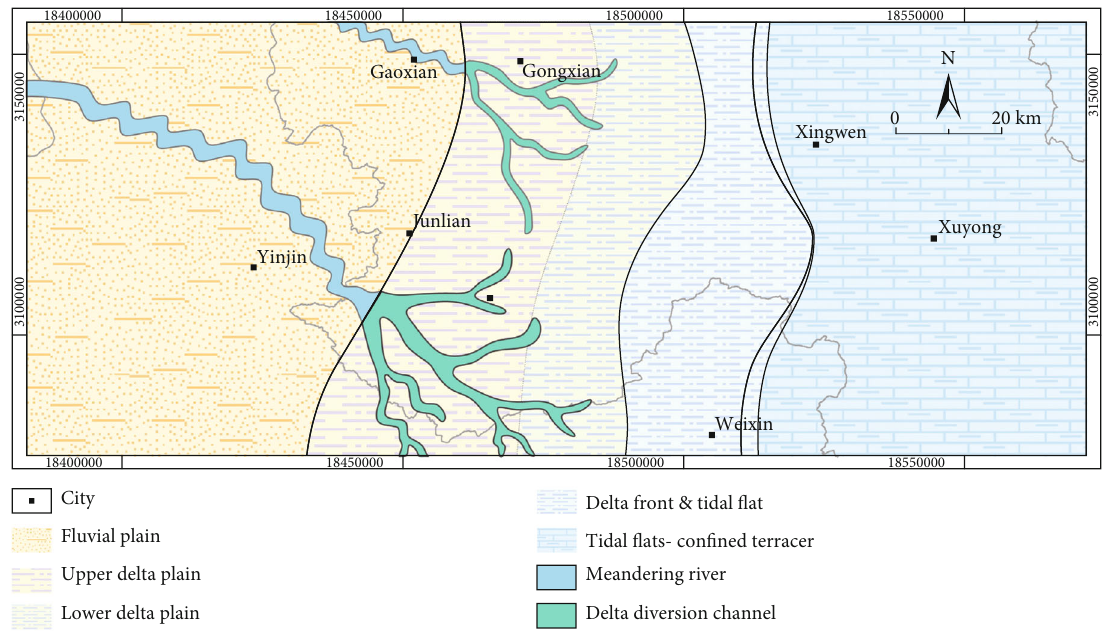
Figure 5: The Lopingian CSIII petrographic paleogeography map of